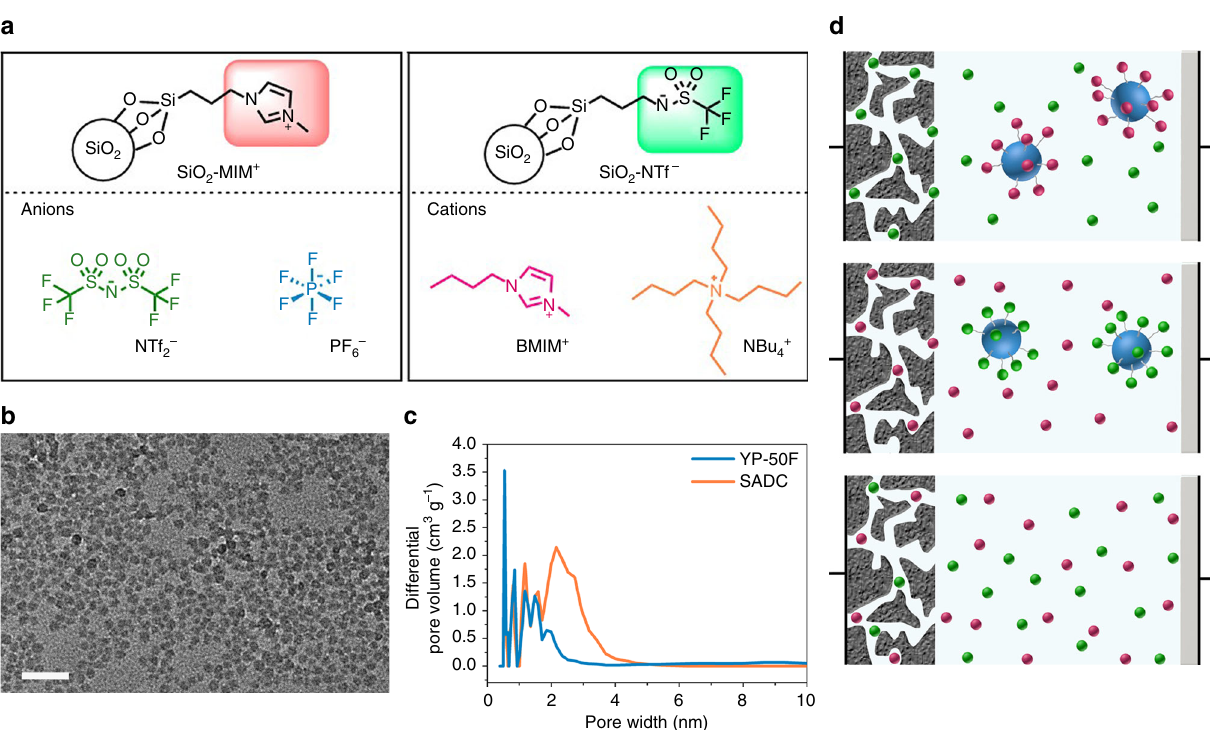
Fig. 1 Schematic of the strategy for respectively characterizing the charging behavior of cations and anions of ionic liquids in electrochemical double-layer capacitors (EDLCs). a Structures of cations, anions, and silica nanoparticle-grafted ions. b Transmission electron micrograph of silica nanoparticles with a uniform diameter of 7 nm. Scale bar, 50 nm. c Pore size distributions of two activated carbons, which indicate that the pore sizes in two activated carbons are smaller than the diameter of silica nanoparticles. d Schematic of charge storage of activated carbon electrodes during polarization in different types of ionic liquids: silica nanoparticle-grafted cations and free anions (top), silica nanoparticle-grafted anions and free cations (middle), conventional cations and anions (bottom). Big blue balls represent silica nanoparticles, small wine balls represent cations, and green balls represent